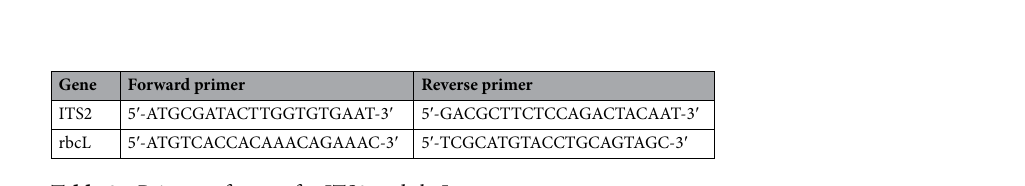
Table 8. Primer reference for ITS2 and rbcL